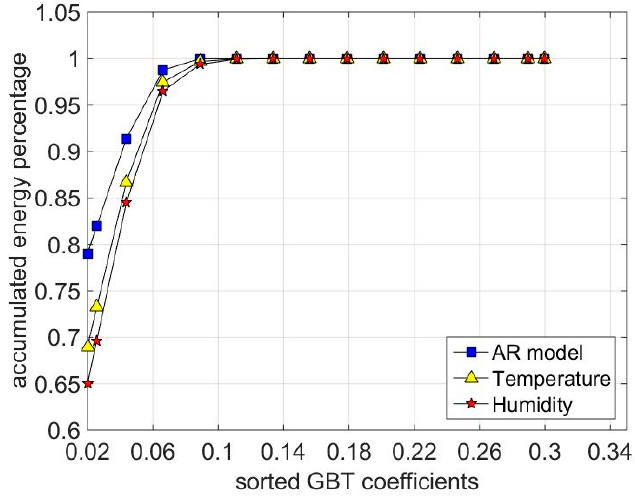
Figure 3. The sorted GBT coefficients of the datasets.